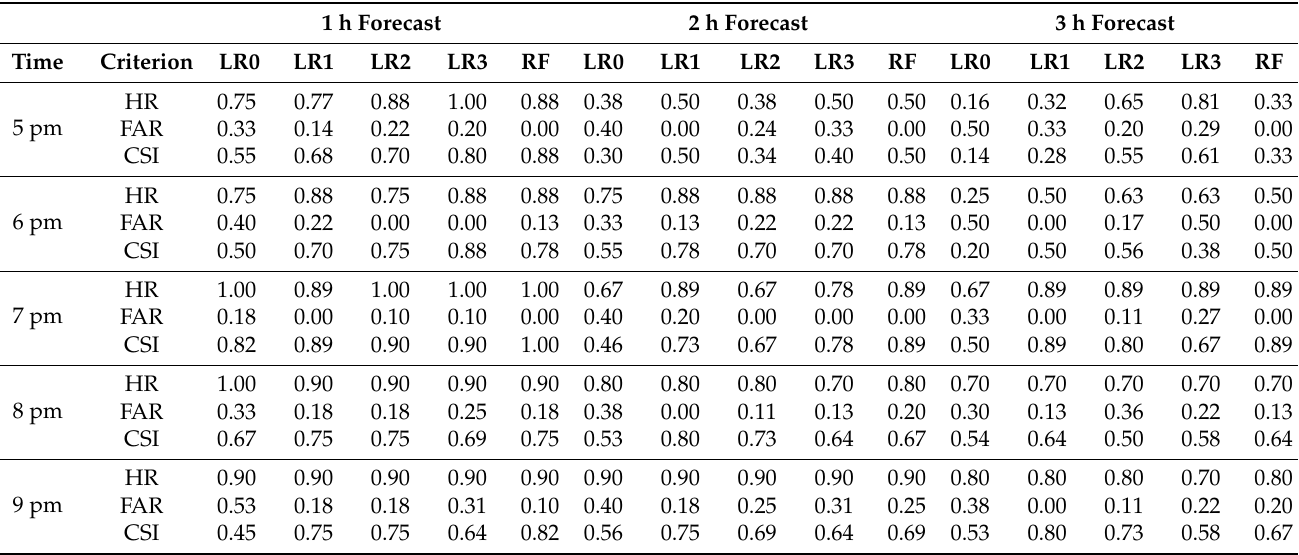
Table 3. Hit rate (HR = TP/(TP + FN); also known as the sensitivity, true positive rate, or recall score), false alarm rate (FAR = FP/(TP + FP); 100% minus precision), and critical success index (CSI = TP/(TP + FP + FN)) of each prediction model by evening